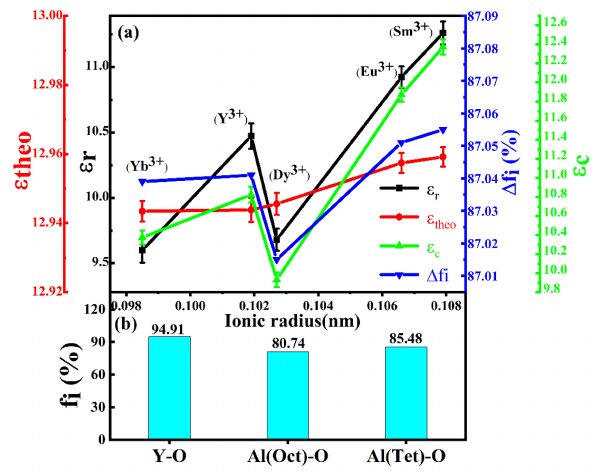
Figure 5. ( a ) ε r , ε theo , ε c and ∆ f i of Y 2.95 R 0.05 MgAl 3 SiO 12 ceramics; ( b ) The average f i of three types of bonds.